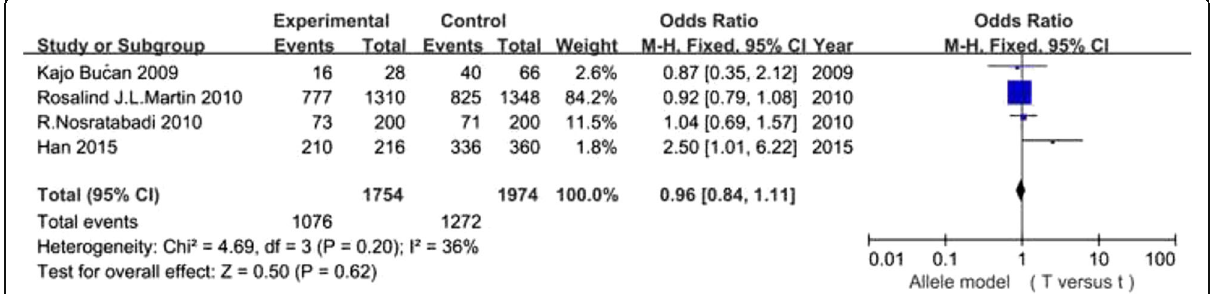
Fig. 4 Association of VDR TaqI gene polymorphism(T vs t) with DN susceptibility in overall populations